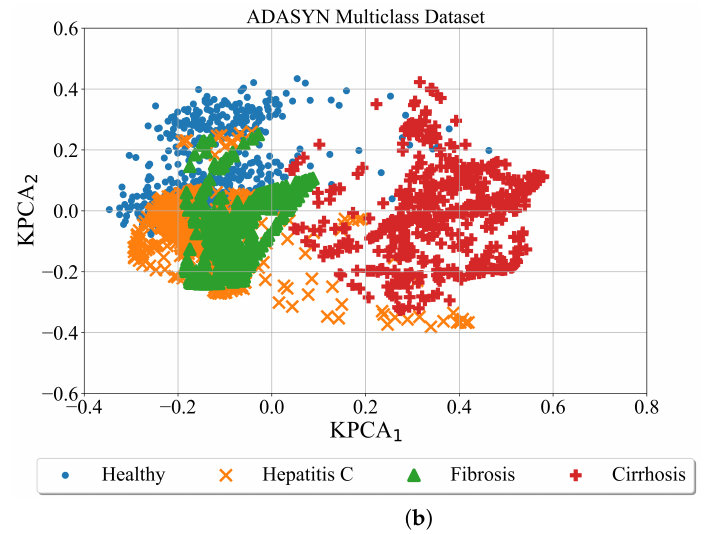
Figure 7. The results of ADASYN oversampling technique application on binary and multiclass dataset. ( a ) ADASYN oversampled Binary Dataset; ( b ) ADASYN Oversampled Multiclass Dataset.